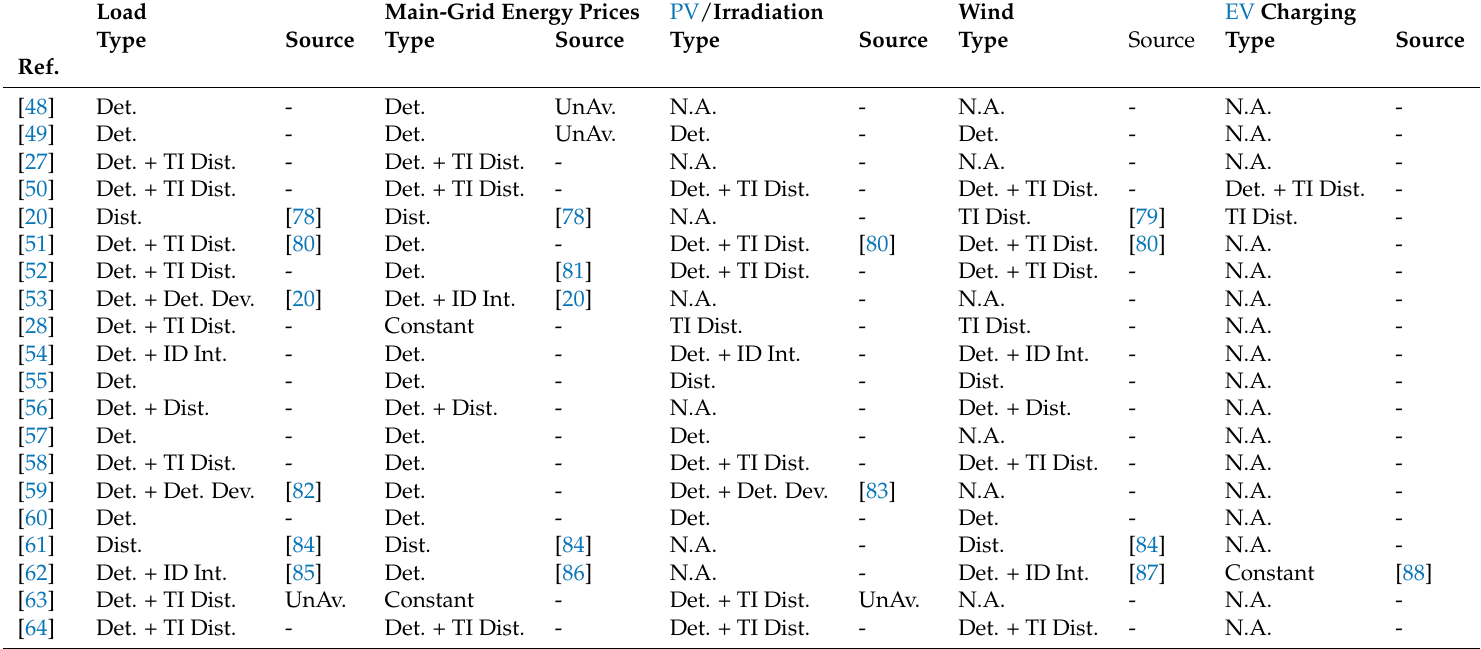
Table 10. Input profiles (Det.: Deterministic, Dist.: Distribution, Int.: Interval, Dev.: Deviation, TI: Temporally Independent, ID: Indeterministic, N.A.: Not Applicable, UnAv.: Source is Unavailable, -: Source is not